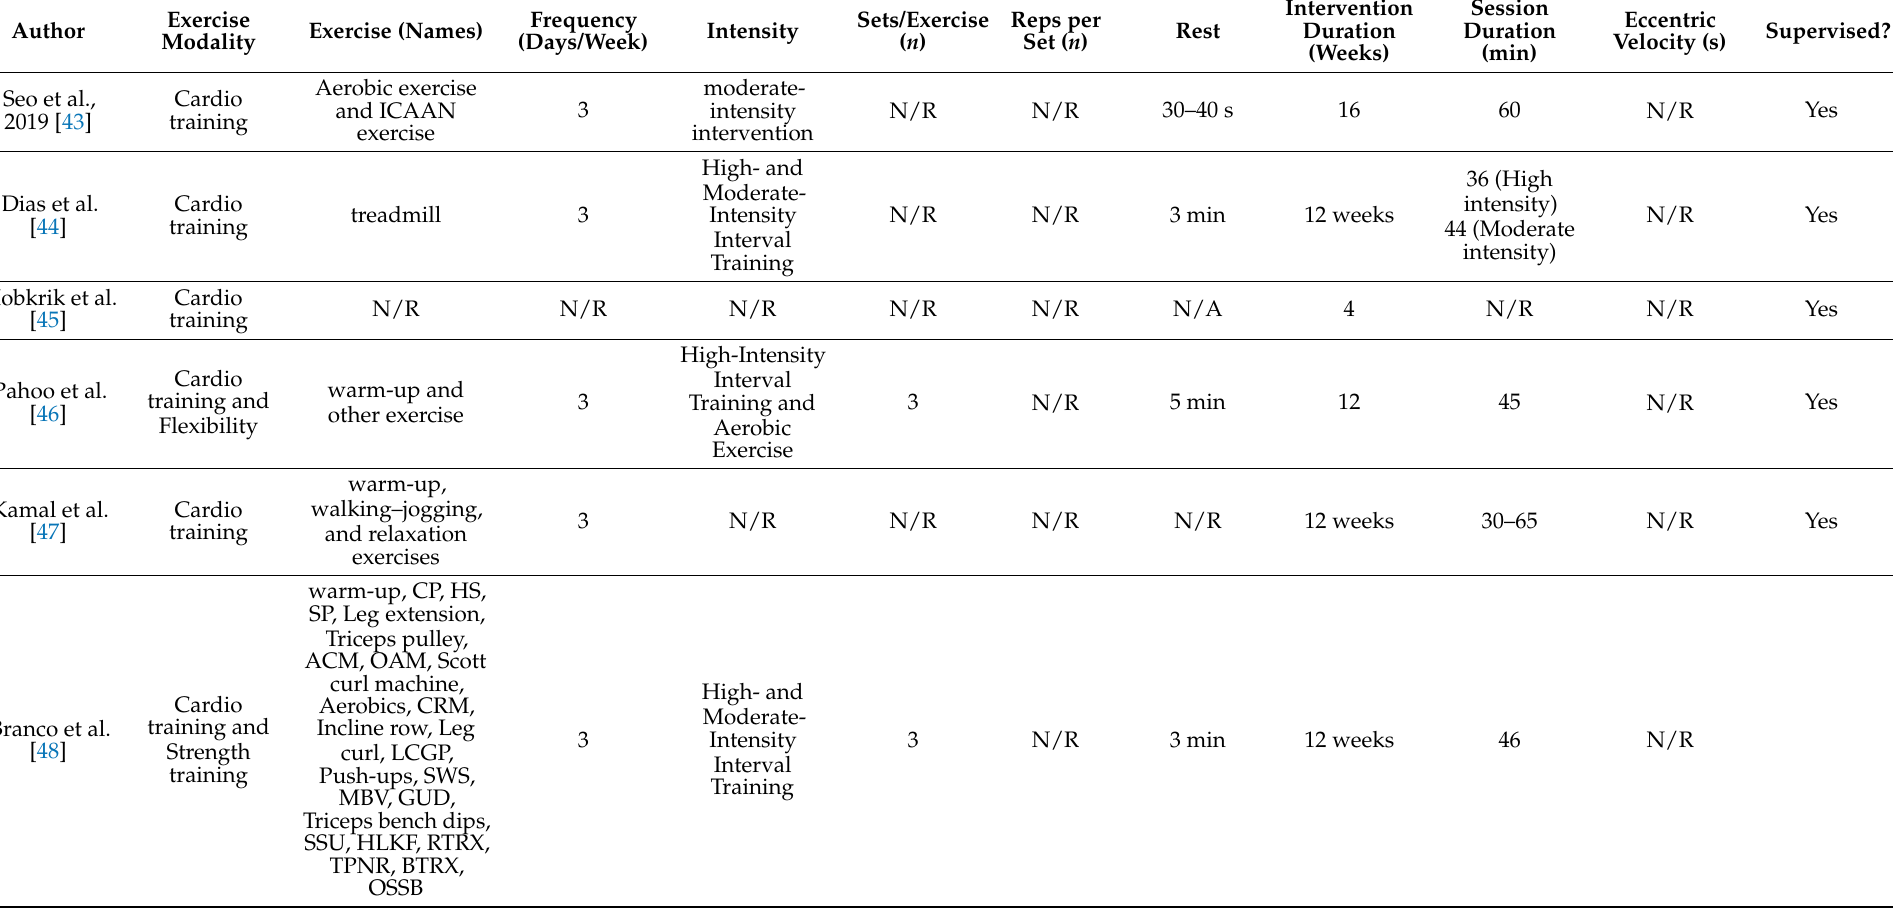
Table 4. Description of the interventions performed in the included